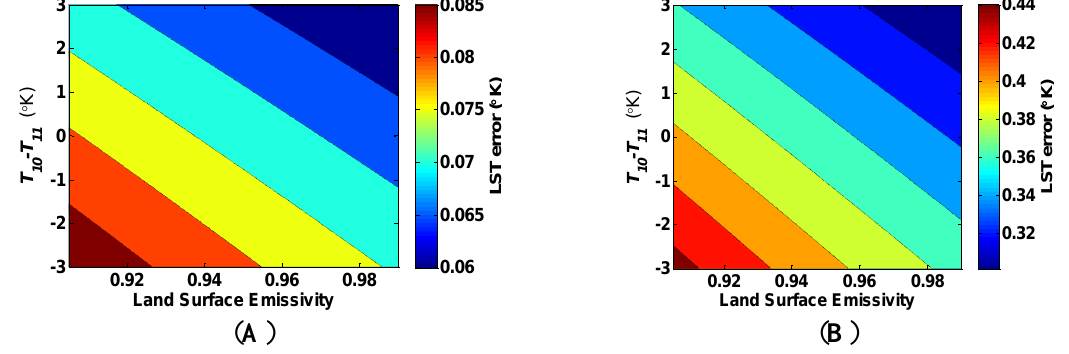
Figure 7. The increase in land surface temperature error (°K) as a result of underestimating the land surface emissivity (LSE) by ( A ) 0.001; and ( B ) 0.005, in both bands as a function of LSE and water vapor content. T